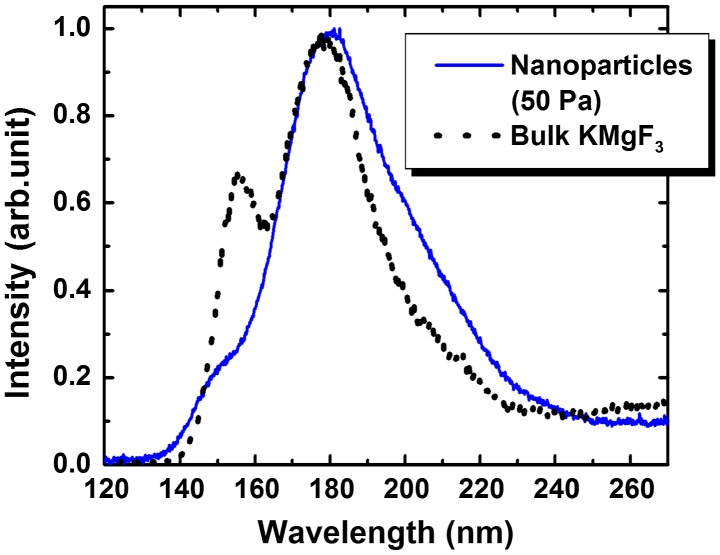
CL spectra of KMgF3 nanoparticles (blue solid line) and bulk KMgF3 (black dotted line).